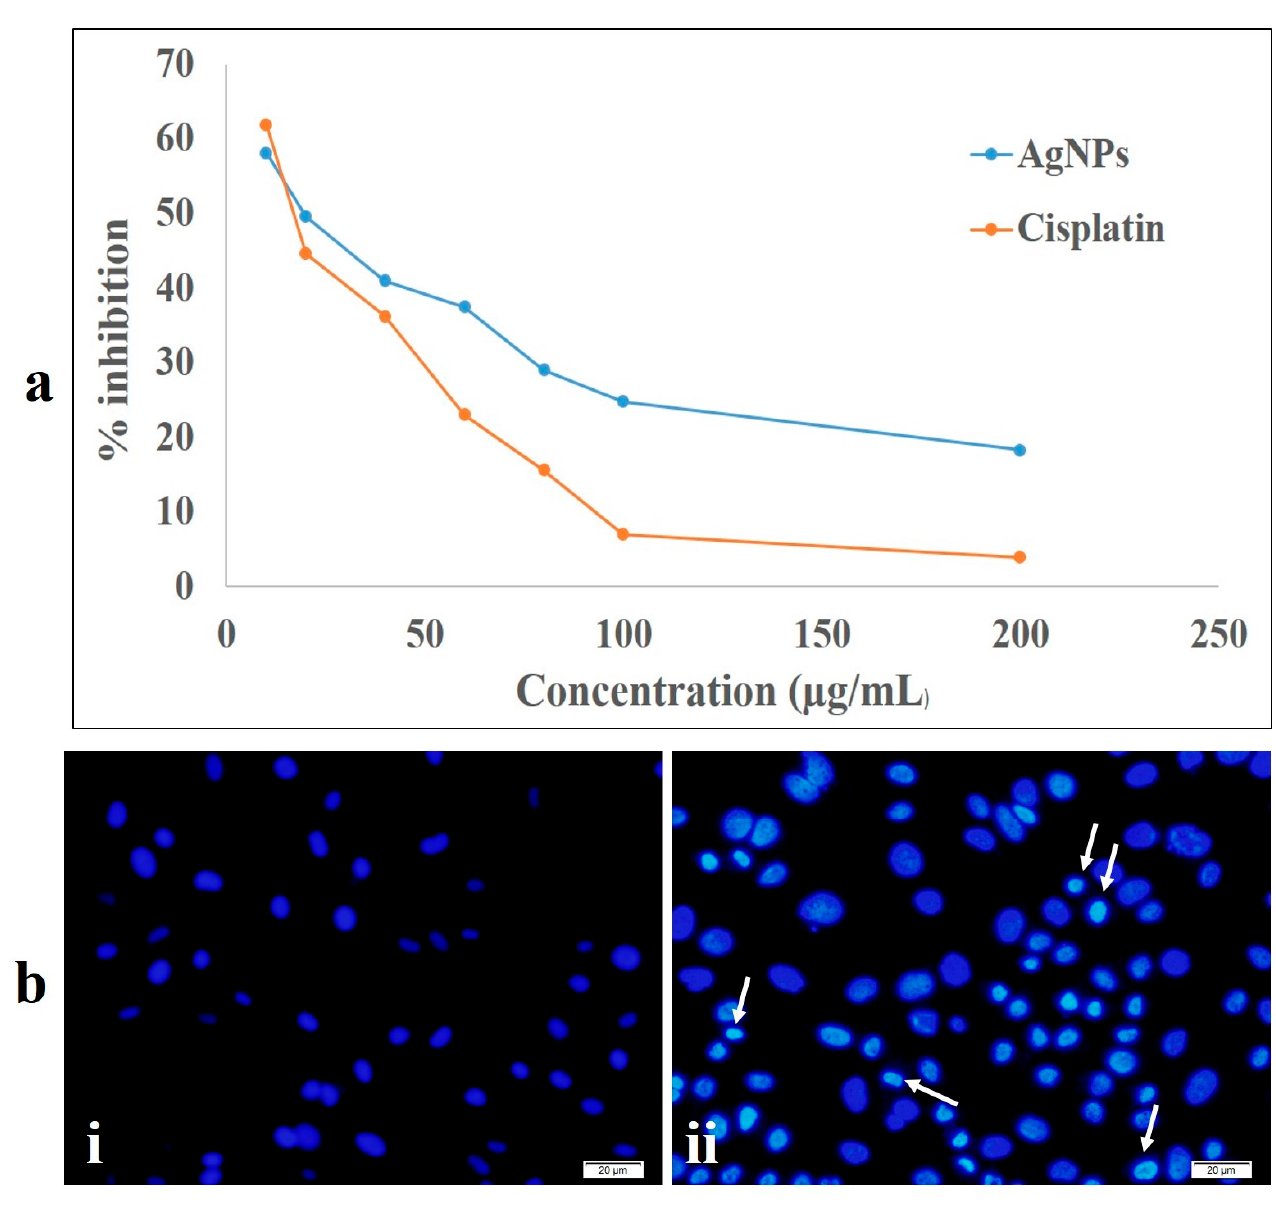
Figure 10. Anticancer activity of the synthesized T. funiculosus –AgNPs against MDA-MB-231 breast cancer cell lines. ( a ) MTT assay; ( b ) Hoechst 33342 staining: (i) untreated cells; (ii) cells treated with TF -AgNPs (white arrows indicate the condensed nuclear material)